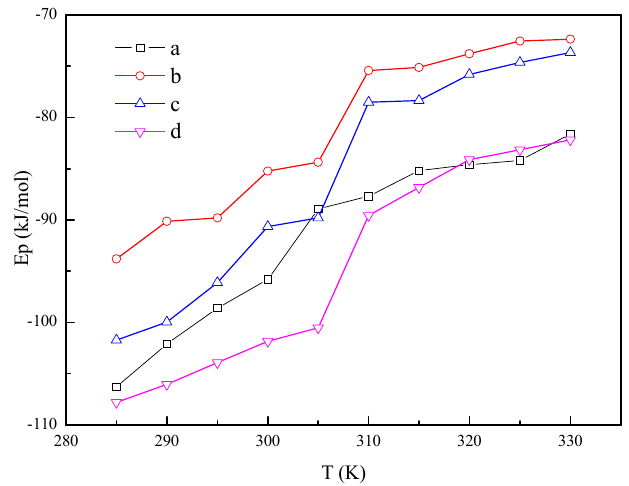
Figure 7. Potential energy of the n -octadecane/Cu nanoparticle nanofluids with different temperatures. ( a ) 128 n -octadecane molecules; ( b ) 1 Cu nanoparticle and 512 n -octadecane molecules; ( c ) 1 Cu nanoparticle and 256 n -octadecane molecules; ( d ) 1 Cu nanoparticle and 128 n -octadecane molecules.